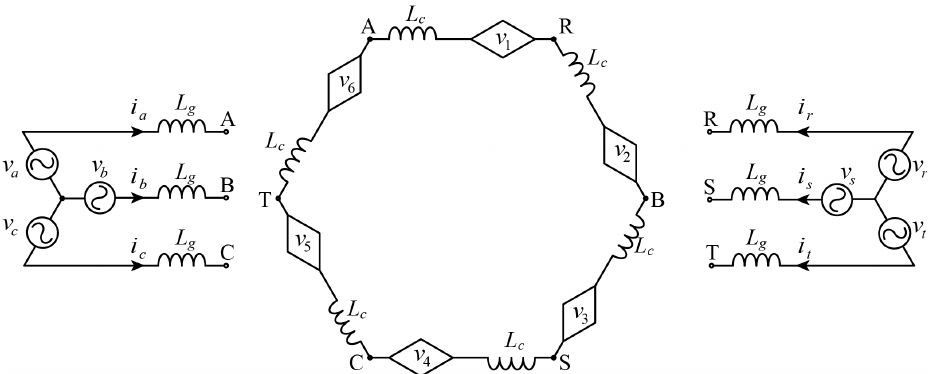
Figure 2. Equivalent circuit of the Hexverter, where the sub-modules are replaced by the equivalent model of a voltage source on the AC side and a current source on the DC